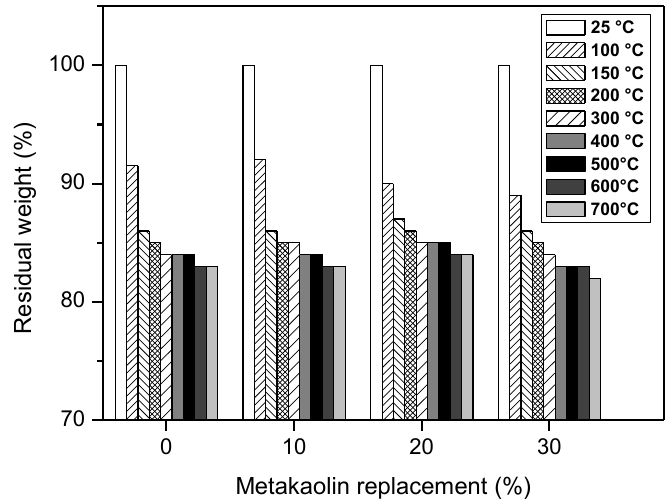
Figure 10. Residual weight and propagation vs temperature at different FBA contents.